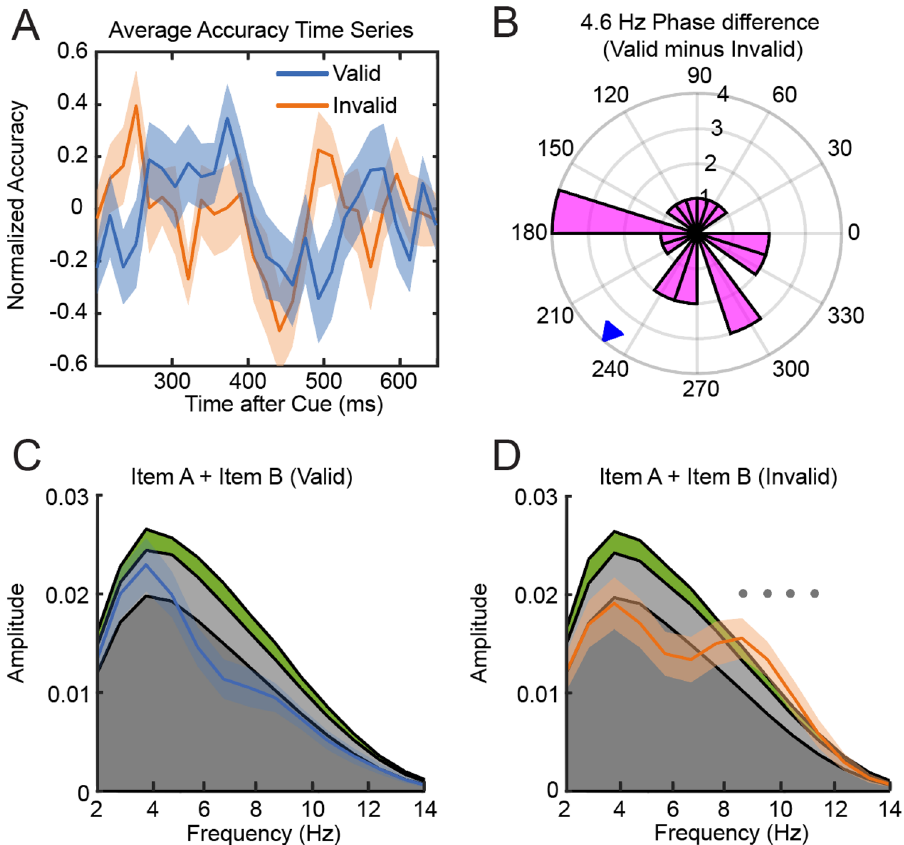
Figure 4. ( A ) Group average accuracy time series for valid and invalid trials. ( B ) 4.6 Hz Phase difference plot. ( C ) Power-spectrum accuracy time series valid condition. Colored areas (dark grey: mean of permutation distribution, light grey < 95% confidence interval, green < 99% confidence interval). ( D ) Same as ( C ) but accuracy time series of Invalid condition. Dots indicate frequencies at which observed spectrum exceeded 95% of samples from permutation distribution (gray: significant before correction for multiple comparisons, black: significant after correction of multiple